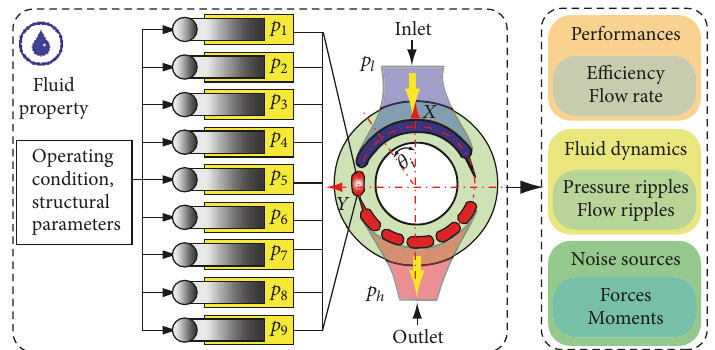
Figure 3: Schematic diagram of the LP model.